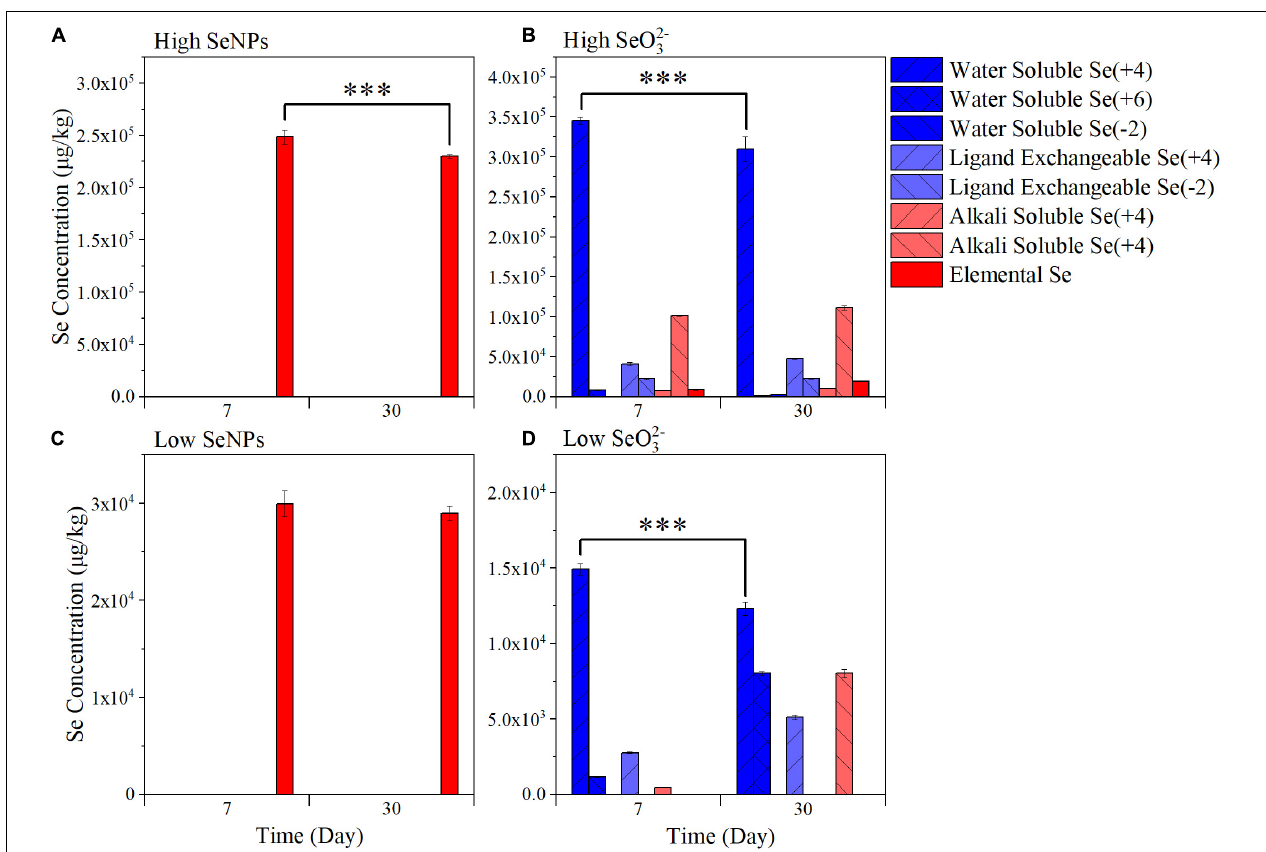
FIGURE 1 | Variation of soil-available selenium (Se) fractions. (A) High selenium nanoparticles (SeNPs): the samples collected from the group treated with 10 mmol/kg soil SeNPs. (B) High selenite (SeO 32 - ): the samples collected from the group treated with 10 mmol/kg soil SeO 32 - . (C) Low SeNPs: the samples collected from the group treated with 1 mmol/kg soil SeNPs. (D) Low SeO 32 - : the samples collected from the group treated with 1 mmol/kg soil SeO 32 - . Significant differences were analyzed by ANOVA; ∗∗∗ p <